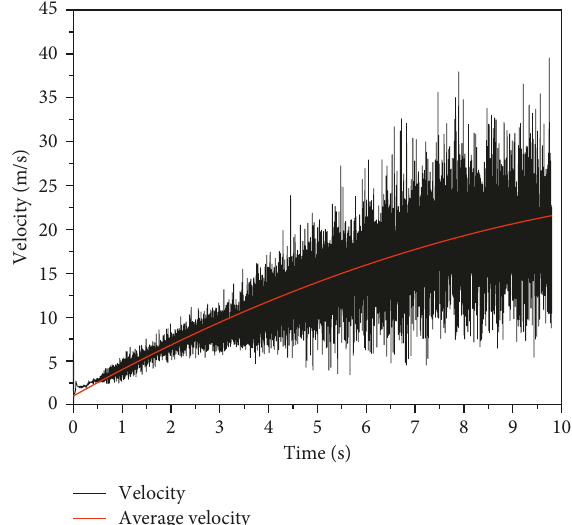
Figure 12: Exit velocity at different times. Figure